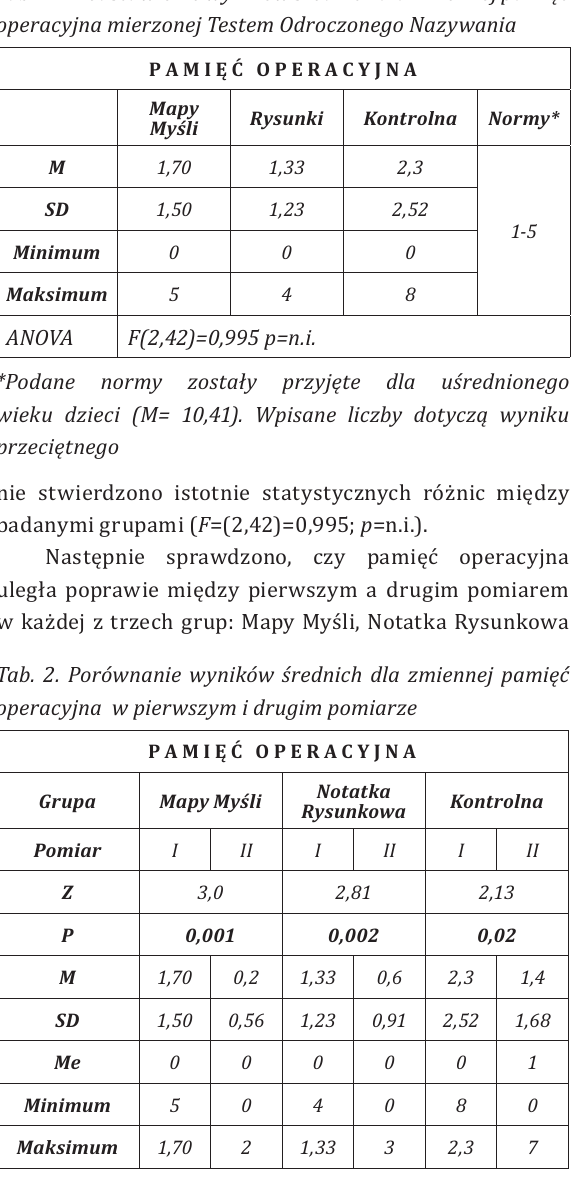
Tab.1. Przedstawienie wyników średnich dla zmiennej pamięć